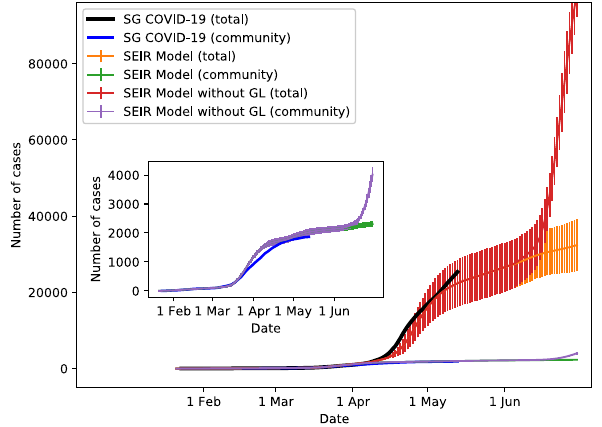
Figure 3. Epidemic curves for the spreading of COVID-19 in Singapore. The curves are shown for the real data, and for the simulated dynamics with and without implementation of the Gradual Lifting (GL) measures. The inset shows an enlarged view of the spreading of COVID-19 within Singapore’s community. Standard deviation is shown as vertical line for the simulated